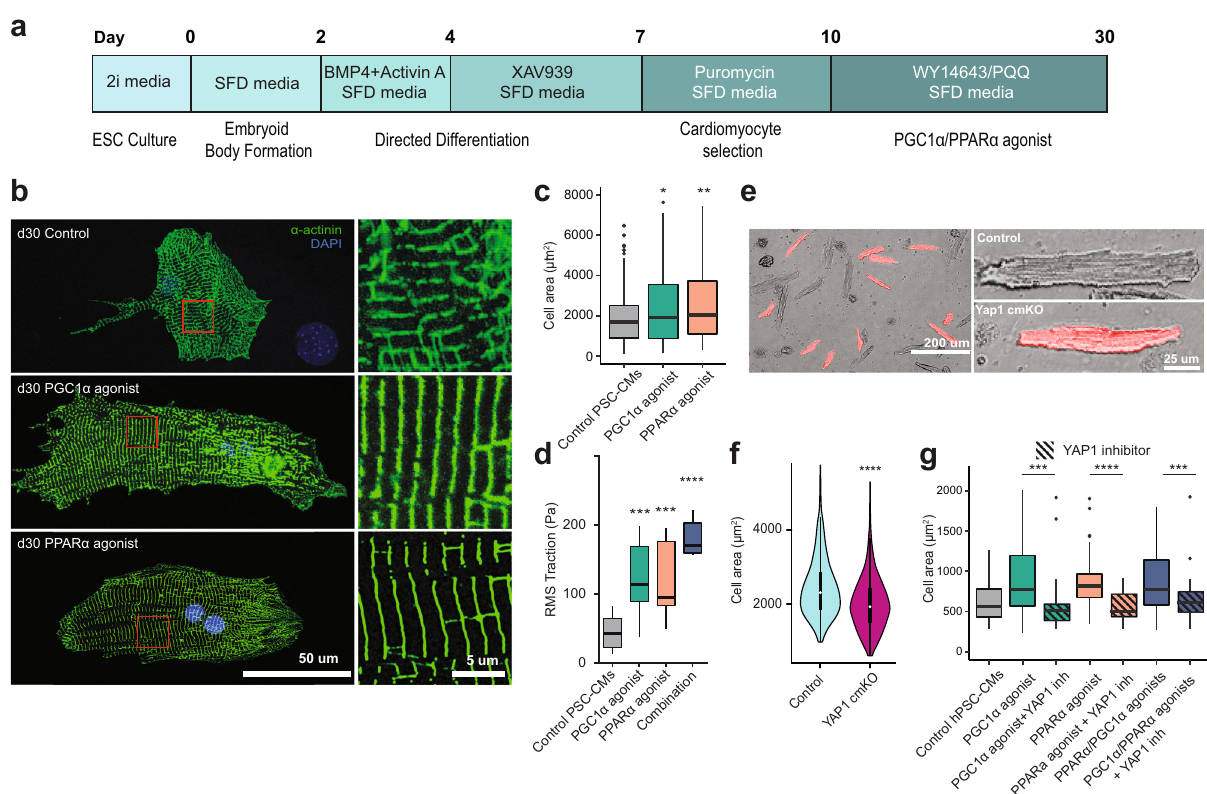
Fig. 5 PGC1/PPAR α promotes PSC-CM hypertrophy through YAP1. a PSC-CM differentiation protocol and treatment timeline showing PGC1 α /PPAR α treatment following differentiation until d30. b Control and PGC1 α /PPAR α agonist-treated mouse ESC-CMs at day 30 (dissociated and replated at low density). The CMs were stained with α -actinin antibody (green) and dapi (blue). Insets show magni fi ed views of boxed areas shown in the left. PQQ 10 μ M, WY14643 1 μ M. c Quanti fi cation of cell area of mouse ESC-CMs treated with PGC1 α (green)/PPAR α (peach) agonists for 15 days. Control n = 192, PGC1 agonist n = 162 ( p -value = 0.012), PPAR α agonist n = 118 ( p -value = 0.0015). ANOVA followed by post hoc Bonferroni test was used. d Fourier transforms traction microscopy showing RMS traction in pascals of control and treated mouse ESC-CMs indicates increased contractility and force production in agonist-treated PSC-CMs. n = 6. e Representative images of control (RFP - ) and Yap1 cmKO (RFP + ) CMs isolated from p32 hearts. f Quanti fi cation of cell area of control and Yap1 cmKO CMs. Control (blue) n = 421, YAP1 (magenta) cmKO n = 335. ( p -value = 1.e − 14) The student ’ s t -test was used. g Cell area measurements for human ESC-CMs treated with PGC1 α /PPAR α agonists in combination with YAP1 inhibitor ((R)-PFI-2 1 μ m). n = 25, 26, 41, 52, 40, 31,